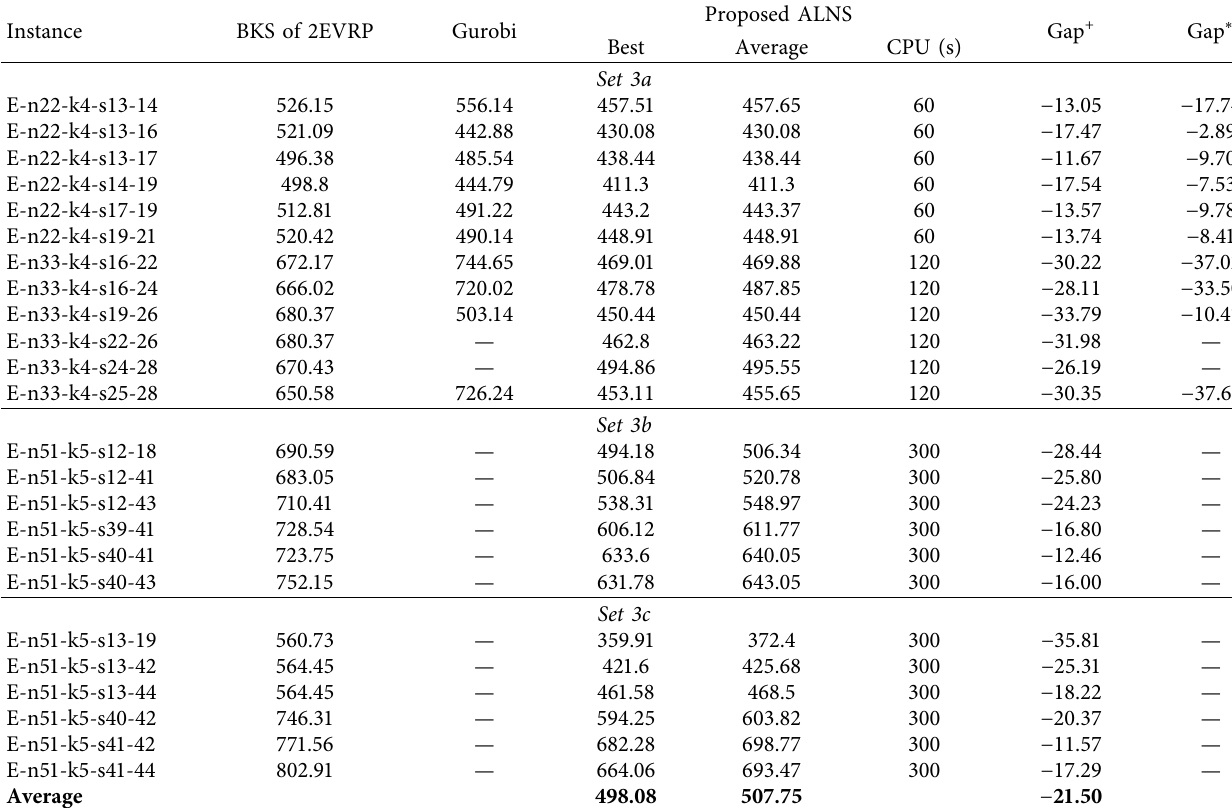
Table 9: Comparison between Gurobi and the proposed ALNS for solving Set 3 instances of 2EVRP-TN-OD. Instance BKS of